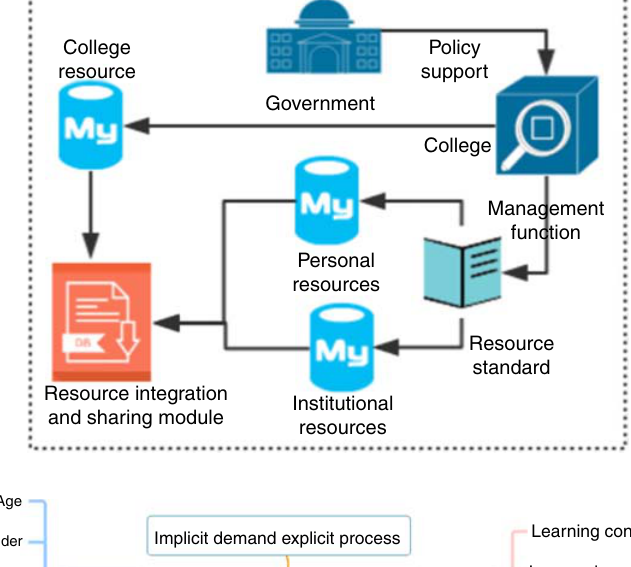
Figure 3. Resource integration